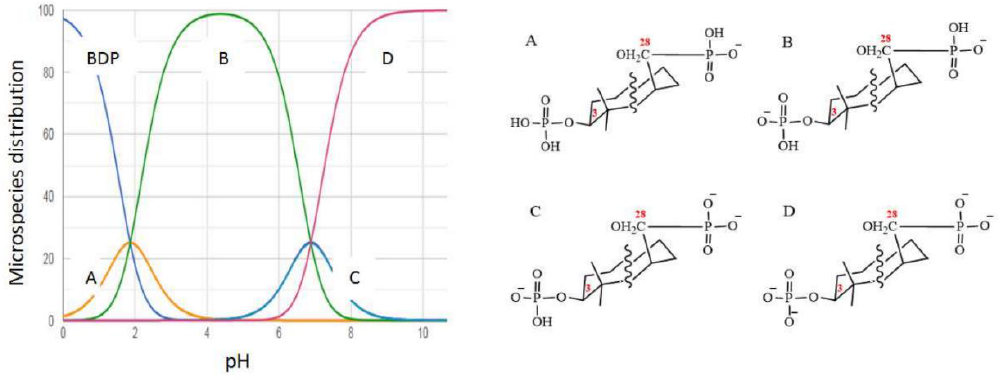
Figure 5. The dependence of BDP microspecies distributions (%) on pH calculated using Chemicalize program [54]. It was shown by electrospray ionization mass spectrometry at 180 °C in methanol that the molecular isotopic mass of BDP is equal to 602.314. It is seen that the spectrum contains one peak corresponding to an ion with a molecular weight of 601.3067 (the peak itself and the isotope distribution for this ion are shown in Figure S3). Consequently, BDP